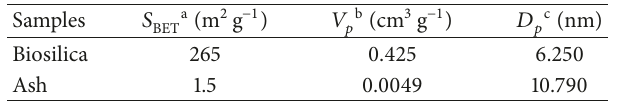
Table 5: Textural properties of biosilica and ash that serve as raw